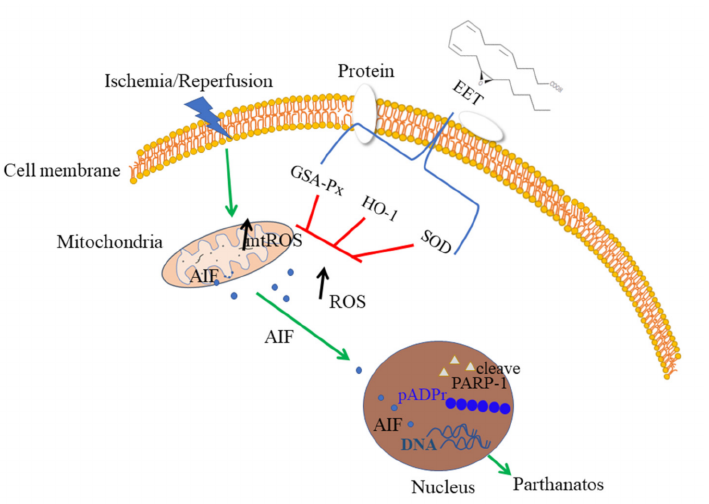
Figure 8. The scheme of neuroprotective function of 14,15-EET. The parthanatos of neurons was caused by the reactive oxygen species being induced by cerebral ischemia and reperfusion. 14,15-EET pretreatment can upregulate the expression of antioxidant genes such as HO-1, GSH-Px and SOD to eliminate reactive oxygen species and inhibit the activation of PARP-1 and nuclear translocation of AIF, reducing neuronal